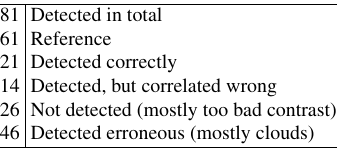
Table 6: Accuracy assessment of detected objects along a 15 km strip of the A96 81 Detected in total 61 Reference